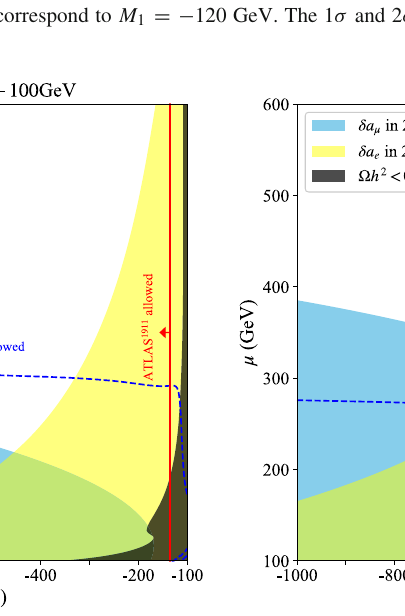
− SM σ and 2 σ levels, e ,μ at 1